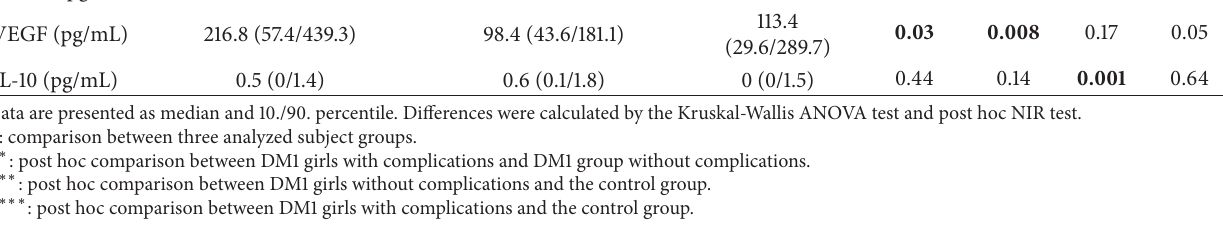
Table 6: The results of the correlation analysis between serum level of 17 𝛽 -estradiol, Th17 subset, and the concentrations of analyzed cytokines in DM1